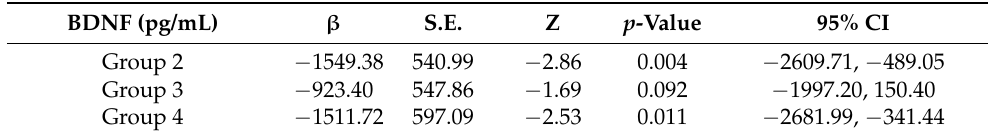
Table 2. Unadjusted linear regression model for the association between insomnia and cognitive decline on BDNF concentration in serum.